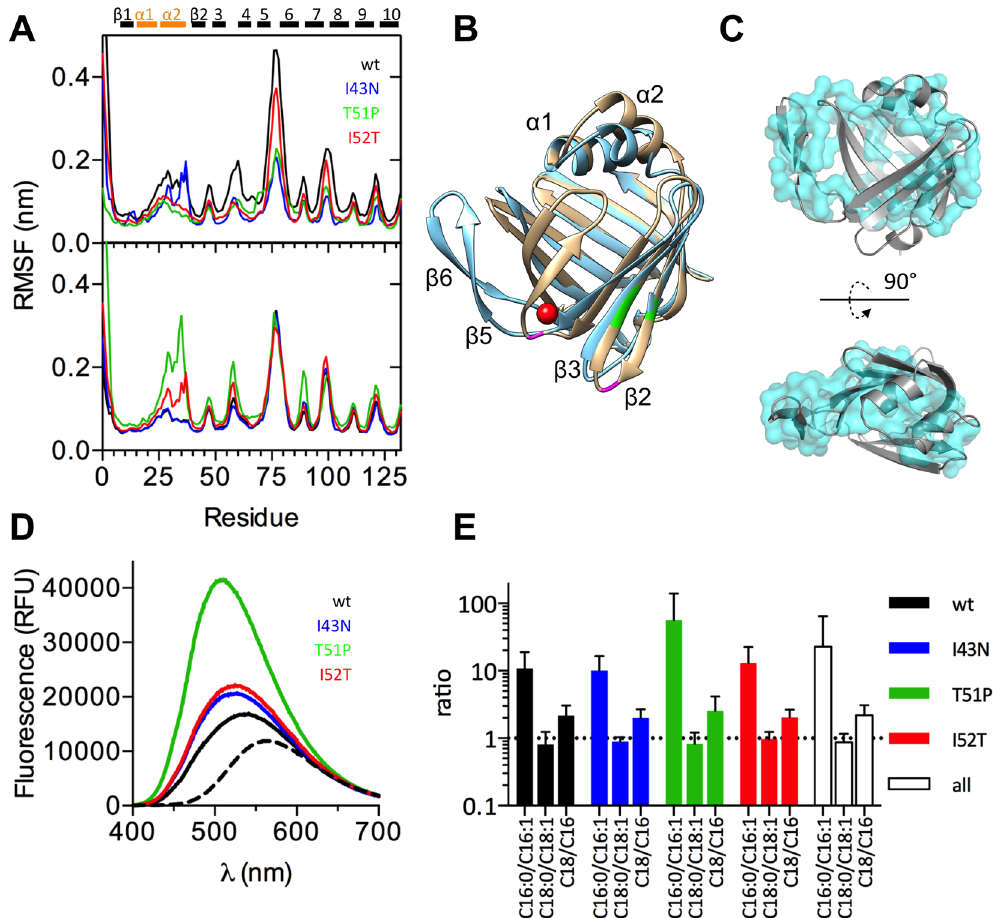
Figure 3. Dynamics, open conformation, and fatty acid binding. ( A ) RMS fluctuation of apo (top) and liganded (bottom) forms. Above the graphs, the secondary structure elements of P2 are shown (black, strand; orange, helix). ( B ) Structure of P2wt (light brown) superimposed on the open conformation of T51P seen in simulations (blue). The two conserved FABP Gly residues in the β 2- β 3 and β 4- β 5 loops are shown in magenta, the positions of the mutations in green, and the “structural” water molecule bound inside the β 4- β 5 loop in FABPs in red. ( C ) Comparison of the open conformation (cartoon) and the SAXS envelope from T51P data (blue transparent surface) from two orientations. ( D ) Fluorescence spectra of DAUDA with 10 µ M proteins. ( E ) LC-MS fatty acid analysis. All P2 variants prefer either palmitate (C16:0) or 18-carbon fatty acids (C18:0 and C18:1) Recombinant P2 carries more C18 than C16 fatty